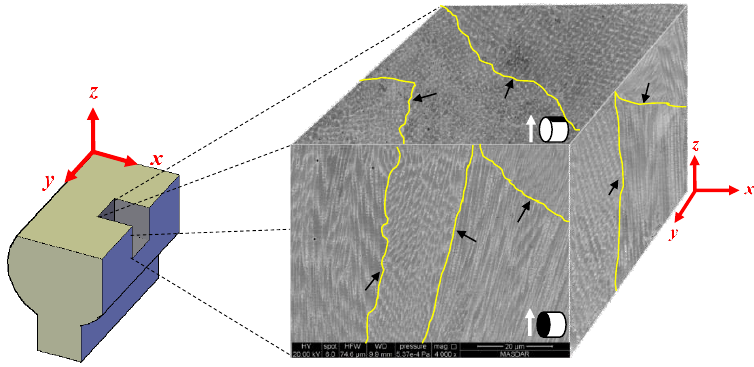
Figure 12. SEM 3D-composite micrograph showing the columnar structure of the SLM-printed cylinder with respect to the building direction. The black arrows are used to indicate the grain boundary lines.